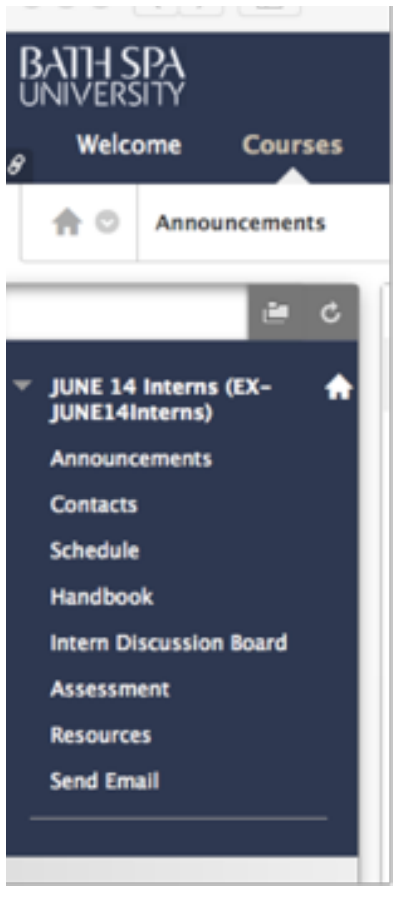
Figure 1. June 14 intern module